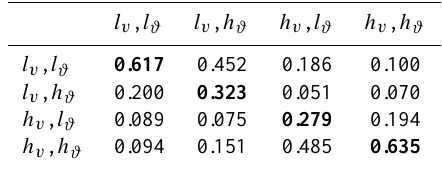
Table 1. Transition matrix b P , estimated from 2380transitions in 120months for the Hawaiian islands. The entries c p ij represent the transition probabilities of changing the state from column j to row i .